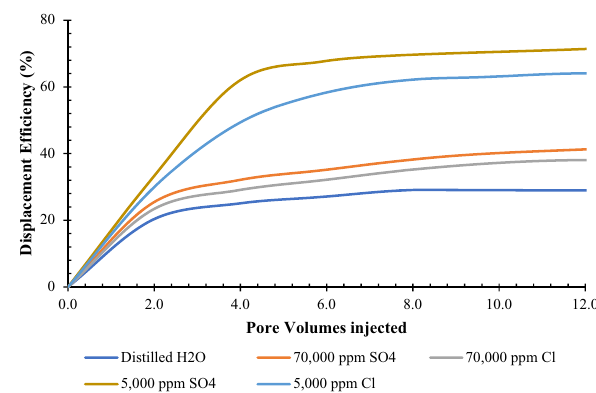
Fig. 11 Comparison of displacement efficiencies of low-salinity brine formulations